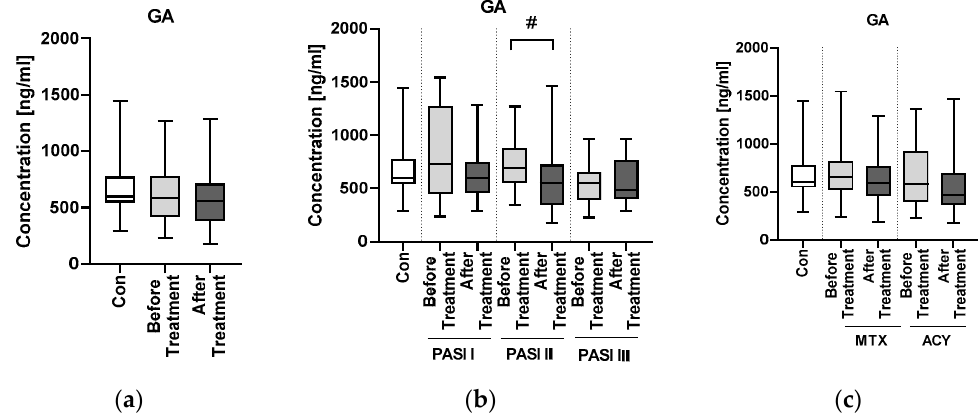
Figure 4. Concentration of GA in patients (before and after the treatments) and controls ( a ); Concentrations of GA in patients (before and after the treatment) according to PASI division, as well as in controls ( b ); GA concentrations in patients (before and after the treatment with methotrexate, MTX, or acitretin, ACY) and controls ( c ). # means statistically significant difference between patients before and after the treatment in PASI II subgroup with p < 0.05.